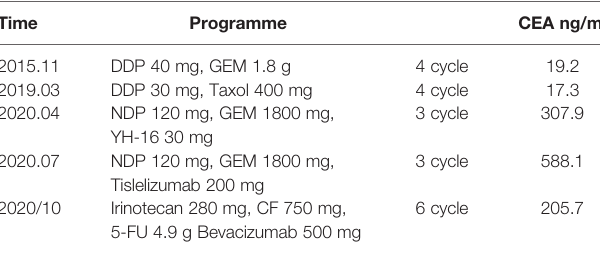
TABLE 1 | Details about the treatments (schedule and dosage).